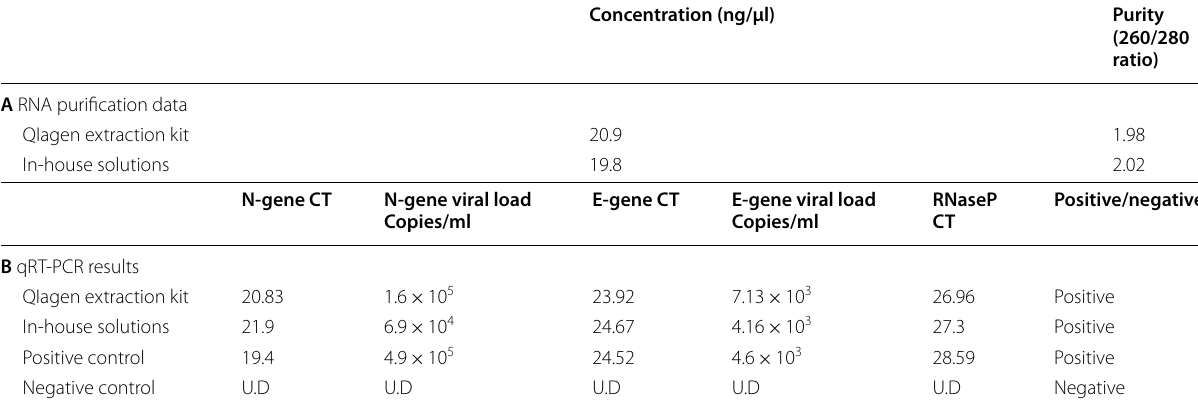
Table 1 RNA purification from a covid-9 positive sputum